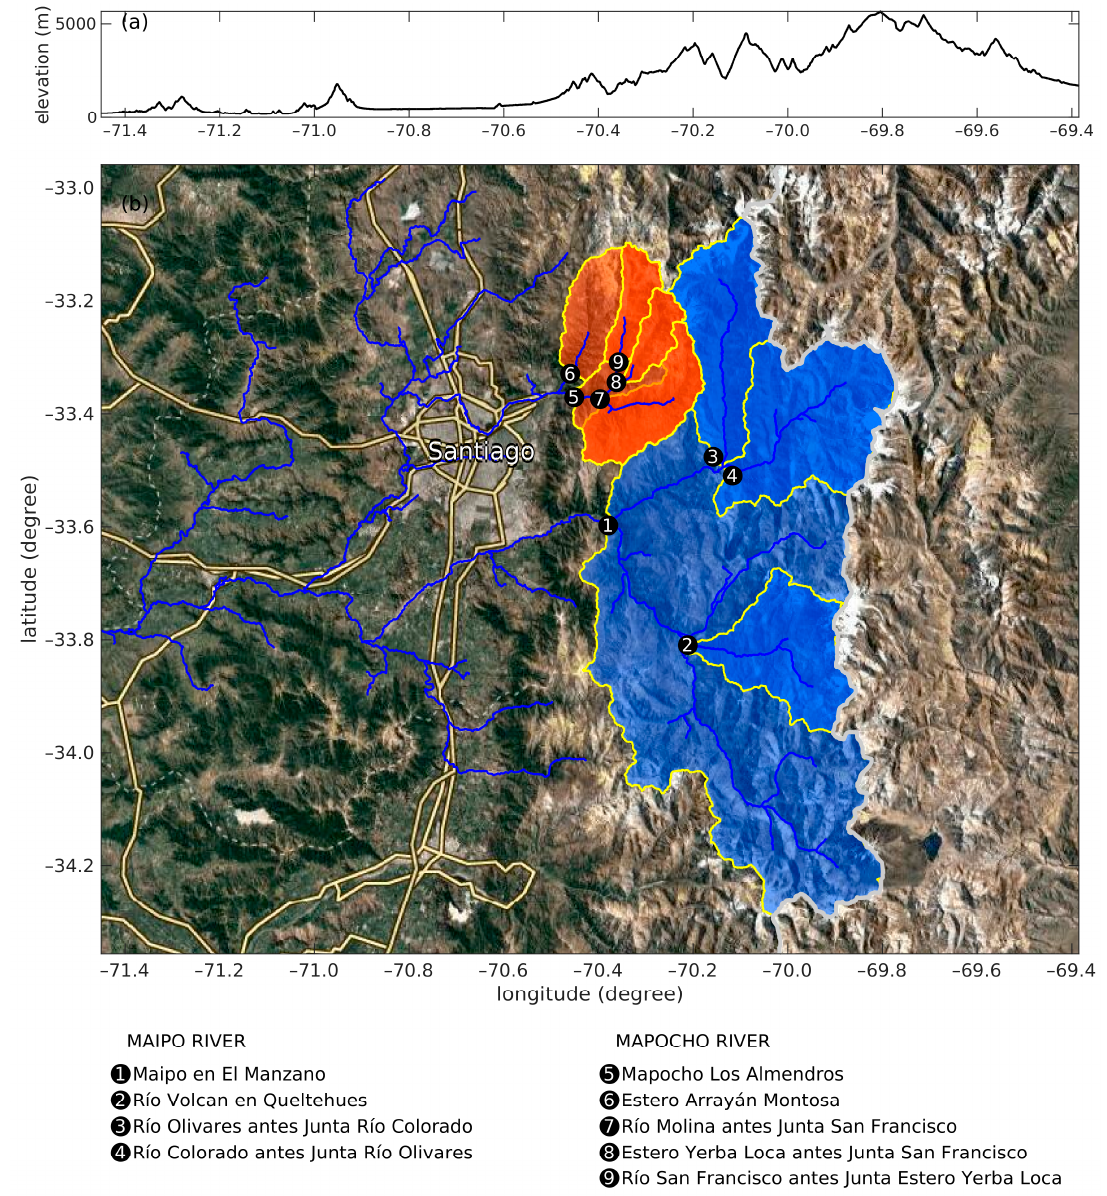
Figure 3. Study site: ( a ) Altitudinal profile along the 33.4° S parallel. ( b ) Map of study area with station location, watershed definition, and glacier location (white areas). Orange watersheds correspond to flow stations in Mapocho River, and blue watershed corresponds to flow stations in Maipo River.